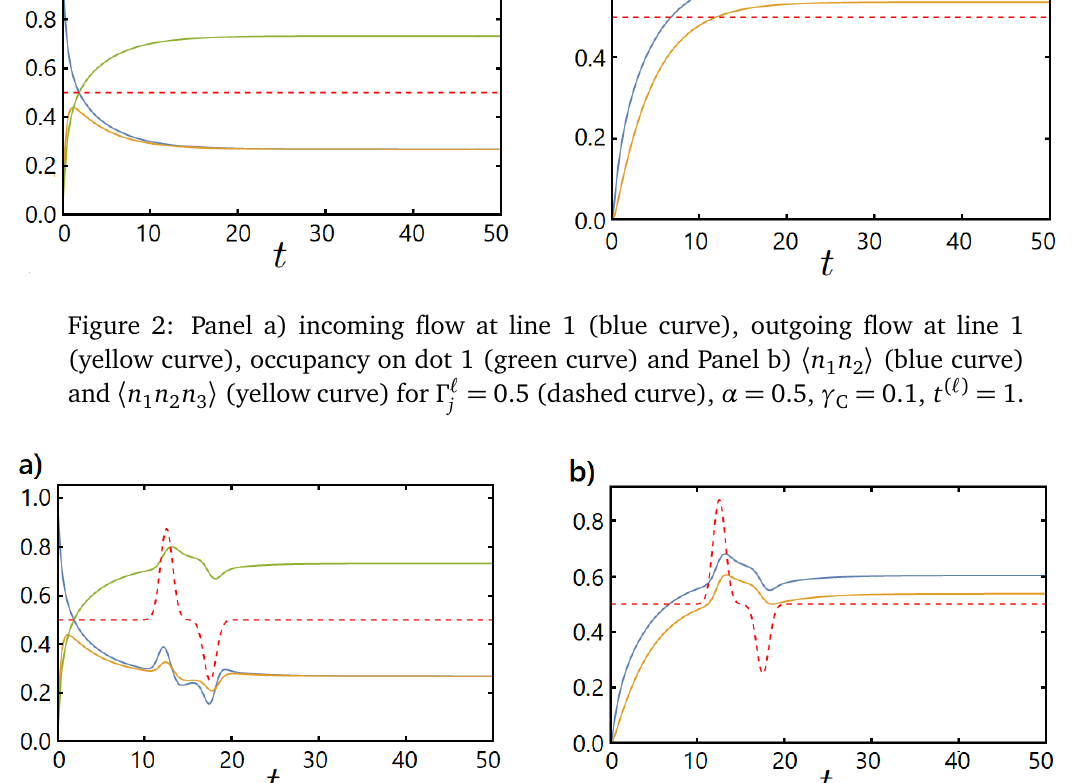
Figure 3: Same as Fig. 2 but with different Γ (cid:96) intersection at time t = 0 with the values of the Γ Fig. 2 we assume constant incoming coupling strength Γ